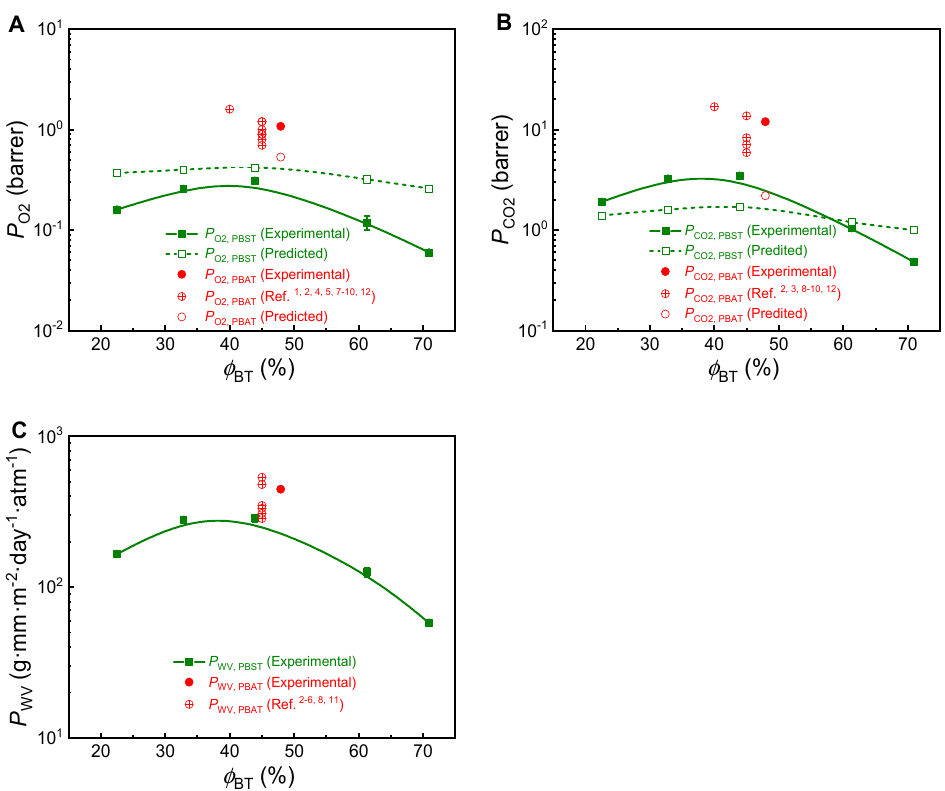
Figure 4. Permeation coefficients of ( A ) oxygen ( P O ( P WV ) in PBST and PBAT. Table 3. and the literature data are from refs. [1–12] and also summarized in Table